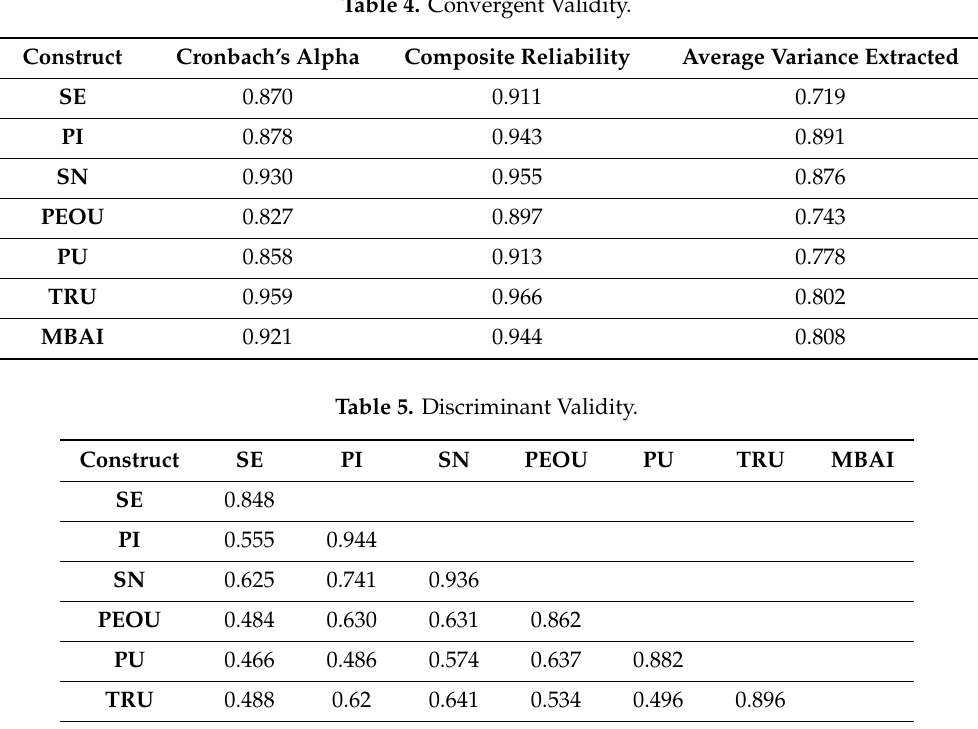
Table 4. Convergent Validity.